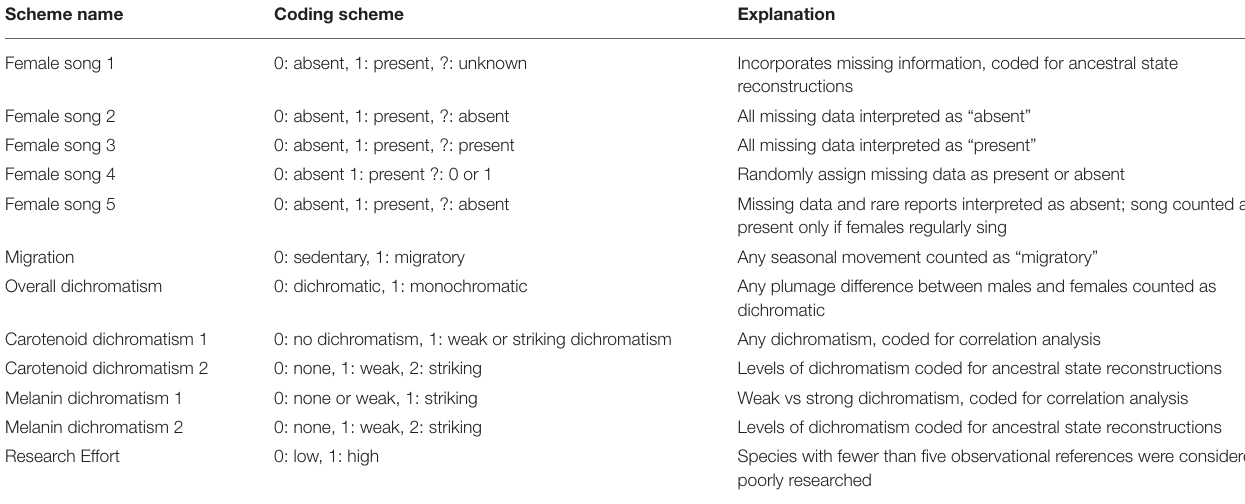
TABLE 1 | Trait coding schemes and